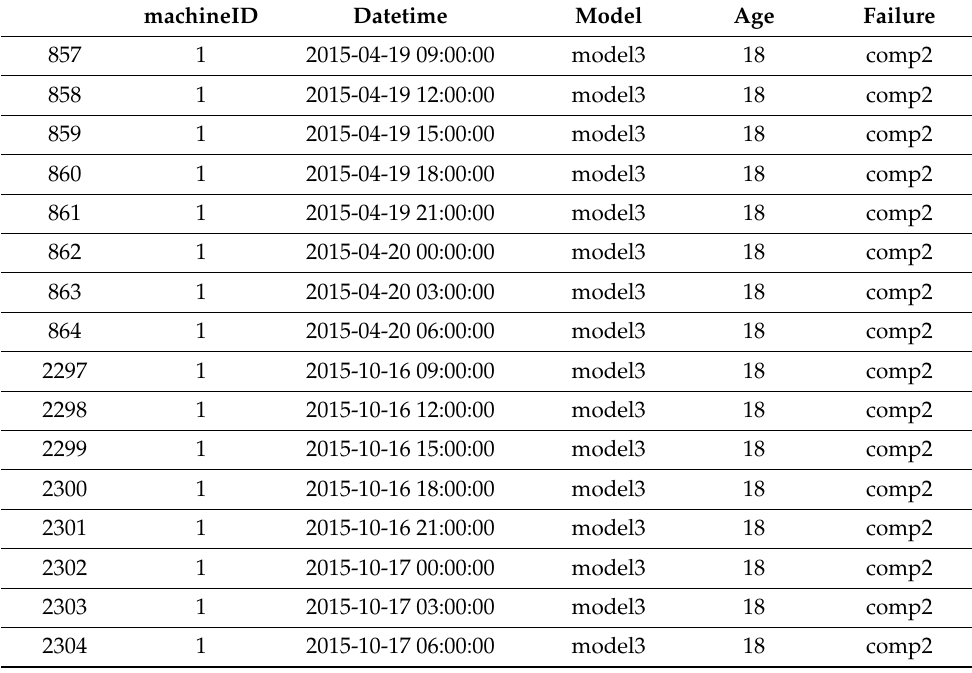
Table 11. Example of failure representation in component